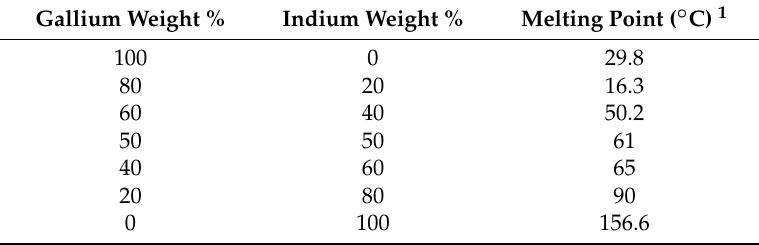
Table 1. Composition of various alloys with their melting